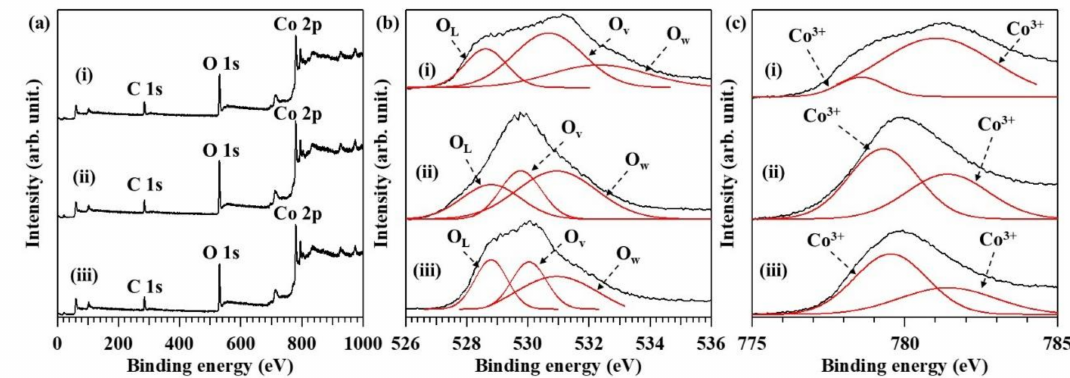
Figure 8. ( a ) Co 2p, O 1s, and C 1s X-ray photoelectron spectroscopy (XPS) spectra; ( b ) O 1s spectra, and ( c ) Co 2p spectra of (i) raspberry-shaped, (ii) randomly shaped, and (iii) cube-like Co 3 O 4